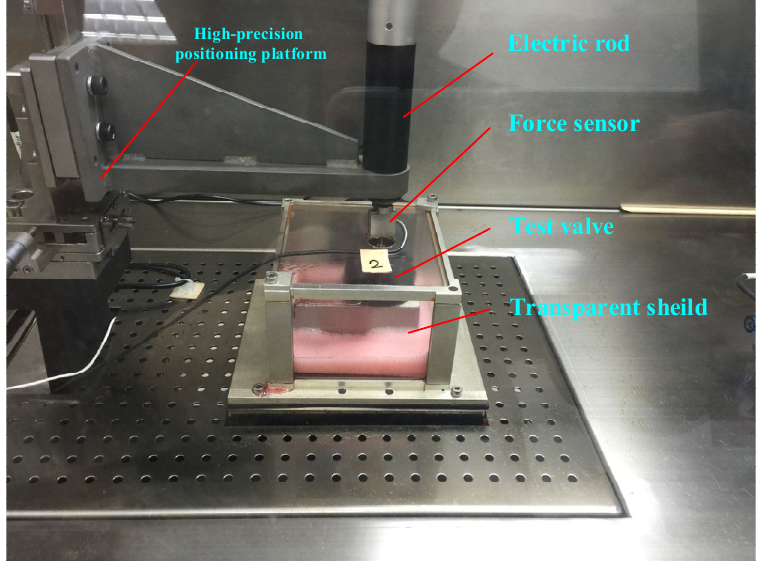
Figure 20. Flow force test rig of Electro-hydraulic servo valve